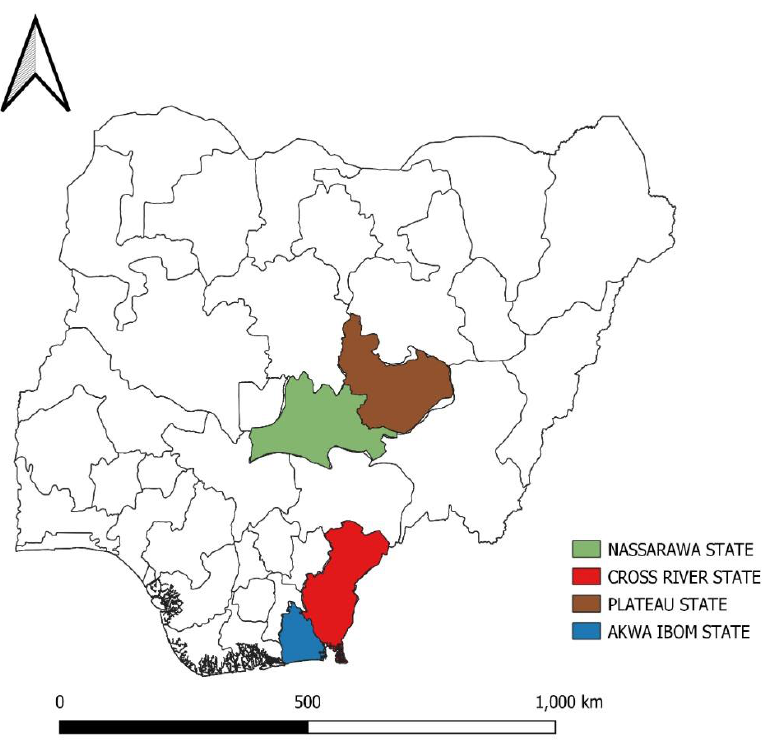
Figure 1. Map of Nigeria showing the locations where the samples were obtained for the